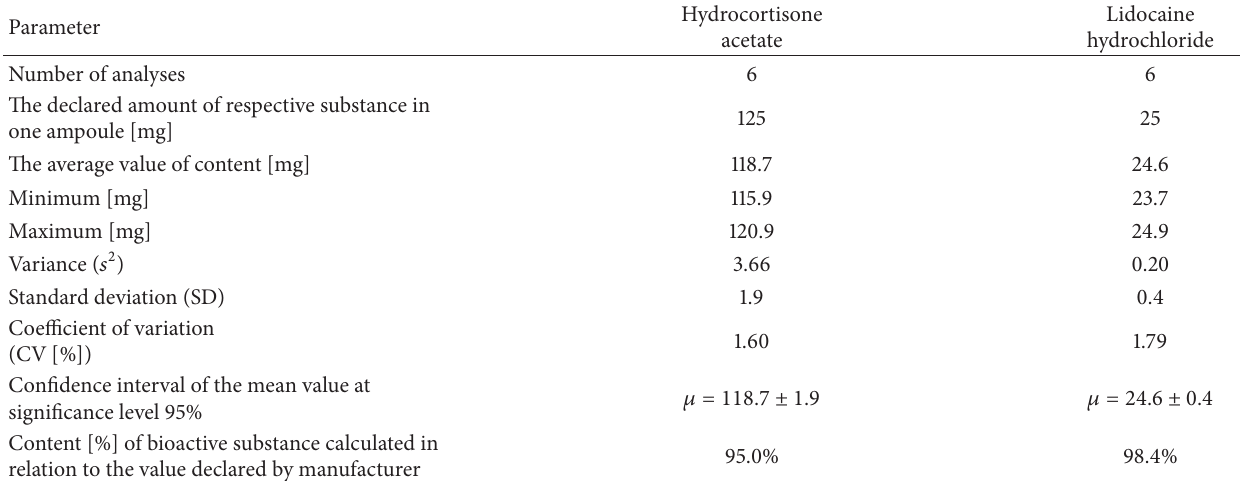
Table 3: Statistical data of the results of quantitative determination of hydrocortisone acetate and lidocaine hydrochloride in injection dosage form of investigated commercial product by NP-TLC with